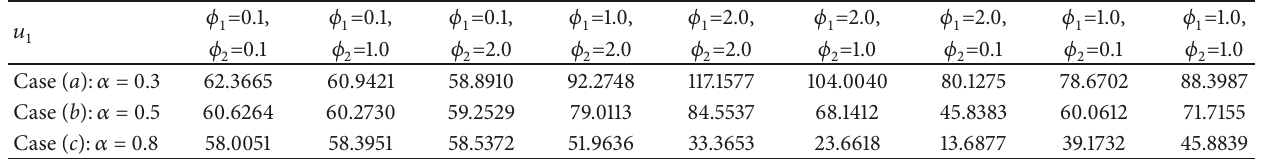
Table 6: The impact of fairness concern on player 1’s expected utility u 1 under three